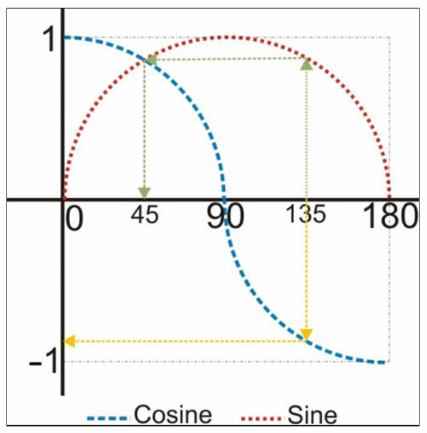
Figure 7. Mistake due to sine theorem